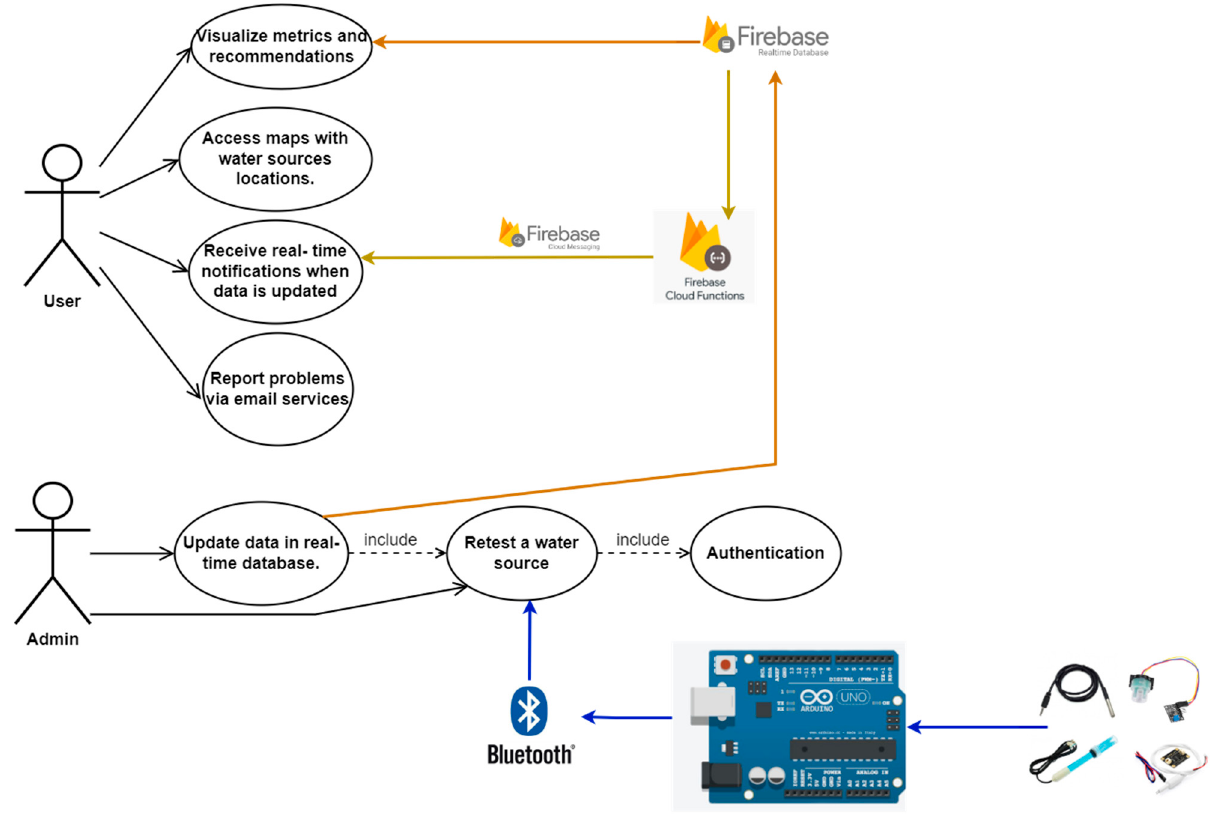
Figure 5. Software architecture of the water status mobile application.